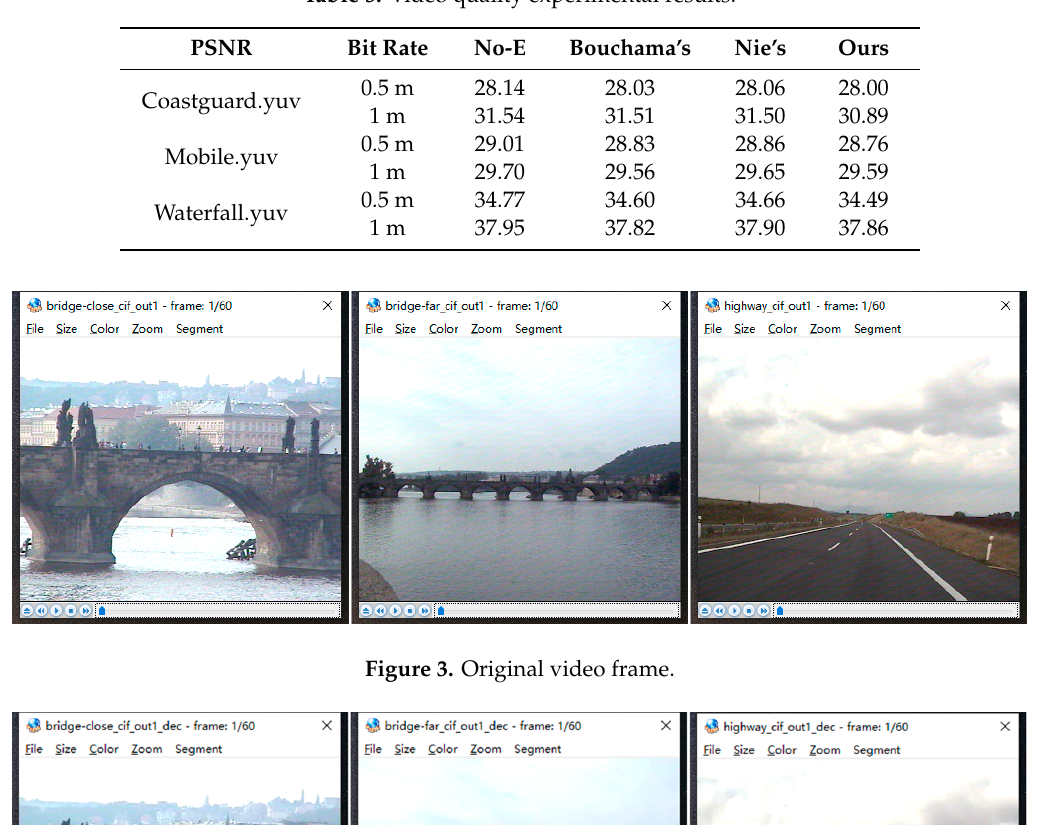
Table 4. Video quality experimental results of the IDR frame.